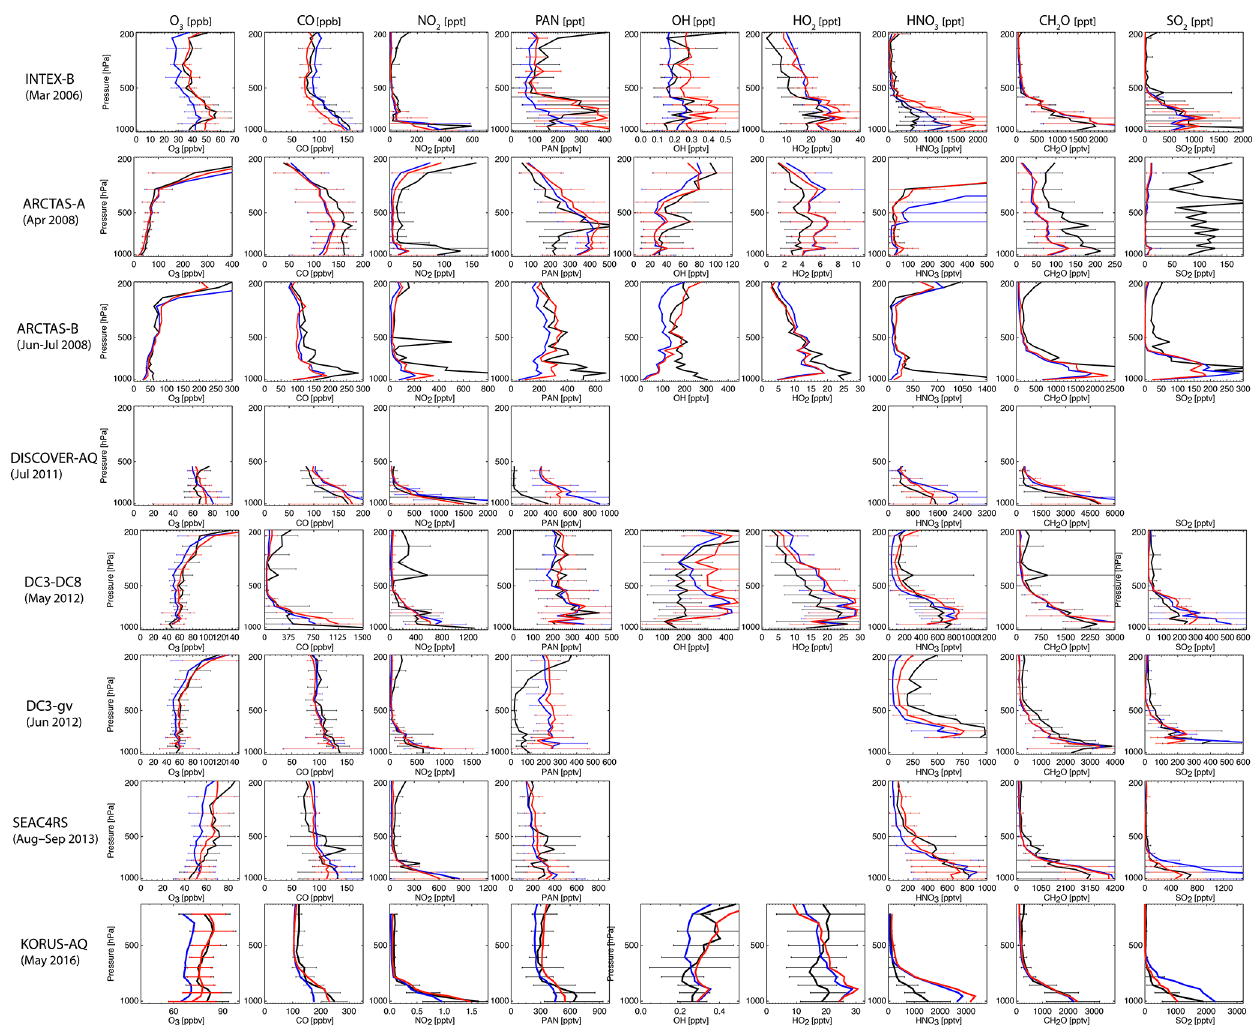
Figure 4. Mean vertical profiles of O 3 (ppb), CO (ppb), NO 2 (ppt), PAN (ppt), OH (ppt), HO 2 (ppt), HNO 3 (ppt), CH 2 O (ppt), and SO 2 (ppt) obtained from aircraft measurements (black), the control run (blue), and reanalysis (red), for the INTEX-B profile (first row), ARCTAS- A profile (second row), ARCTAS-B profile (third row), DISCOVER-AQ profile (fourth row), DC3–DC8 profile (fifth row), DC3-GV profile (sixth row), SEAC4RC profile (seventh row), and KORUS-AQ profile (eighth row). Error bars represent the standard deviation of all data within one bin (with an interval of